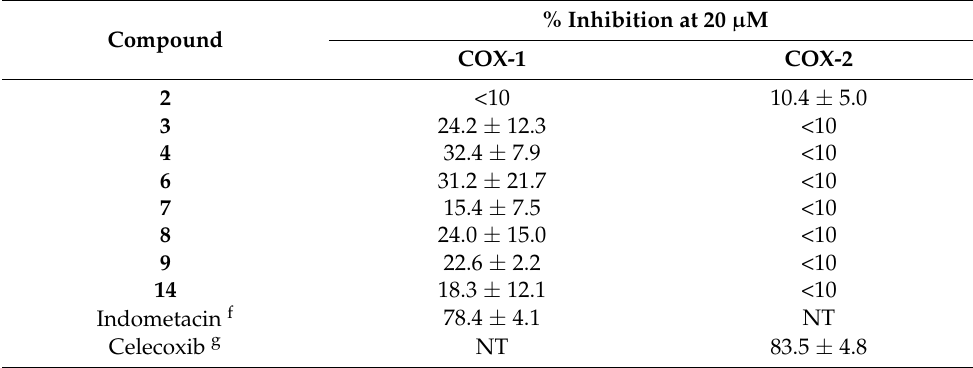
Table 4. Inhibitory activity e of the isolated compounds against COX